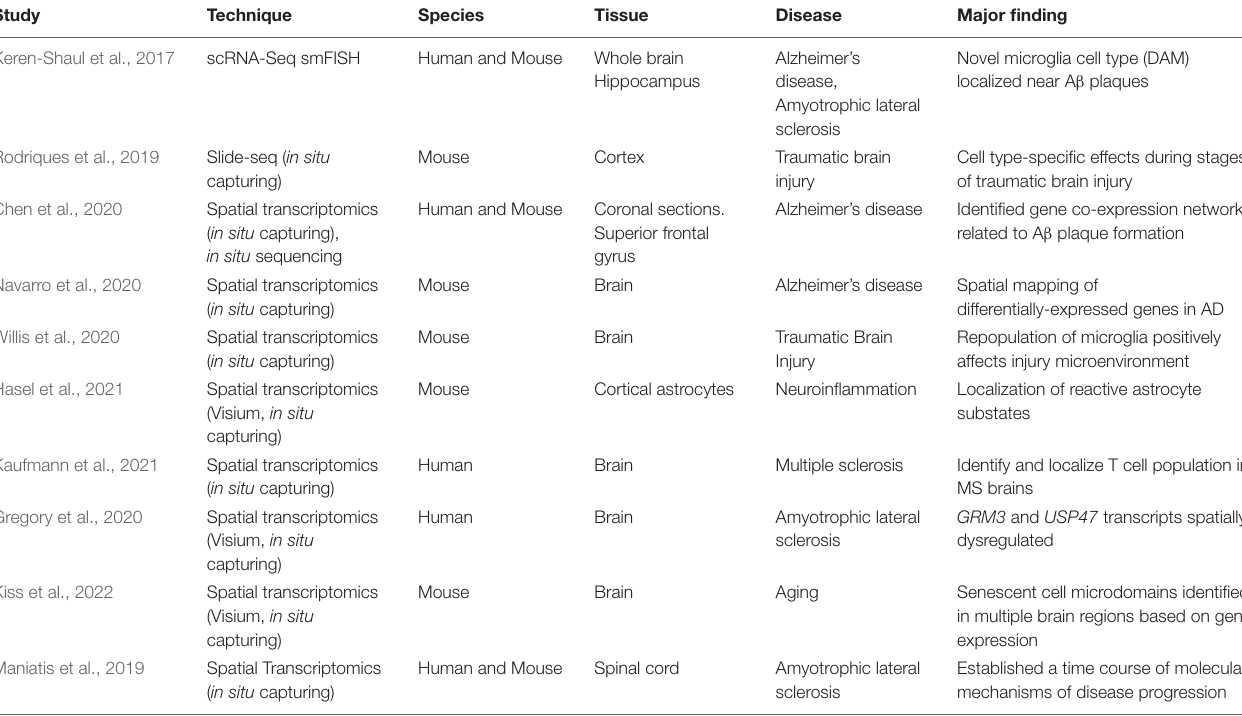
TABLE 4 | A selection of studies using spatially-resolved transcriptomic methods to study brain function and